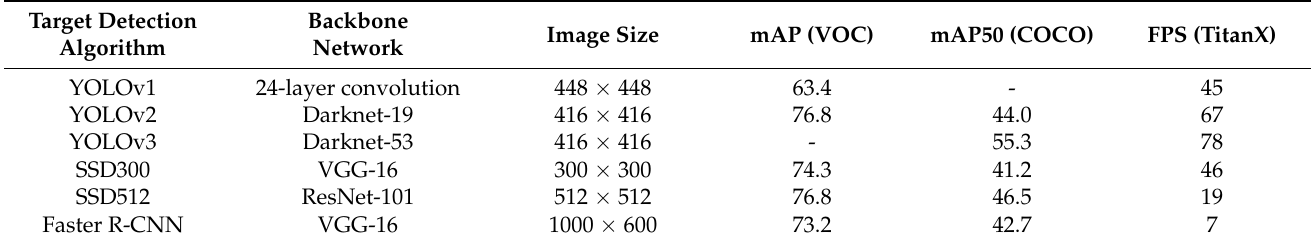
Figure 9. The development flow chart of typical target detection algorithms. Table 4. Performance parameter table of typical target detection algorithms.